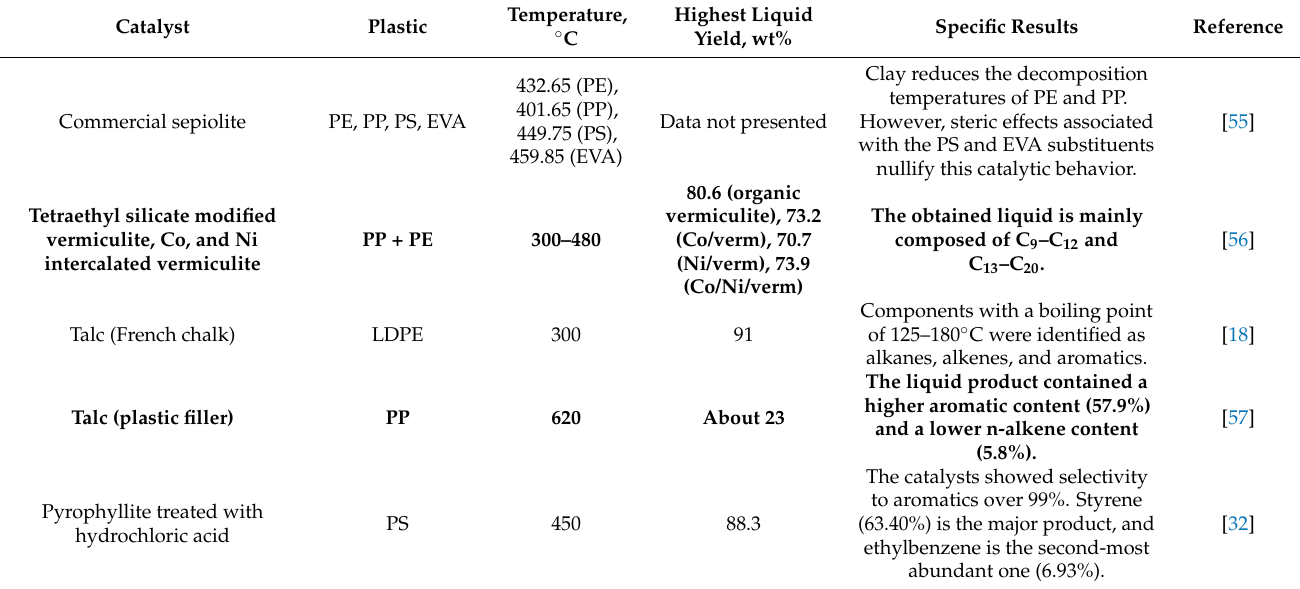
Table 3. Publications on the conversion of different plastics over sepiolite, talc, pyrophyllite, and vermiculite